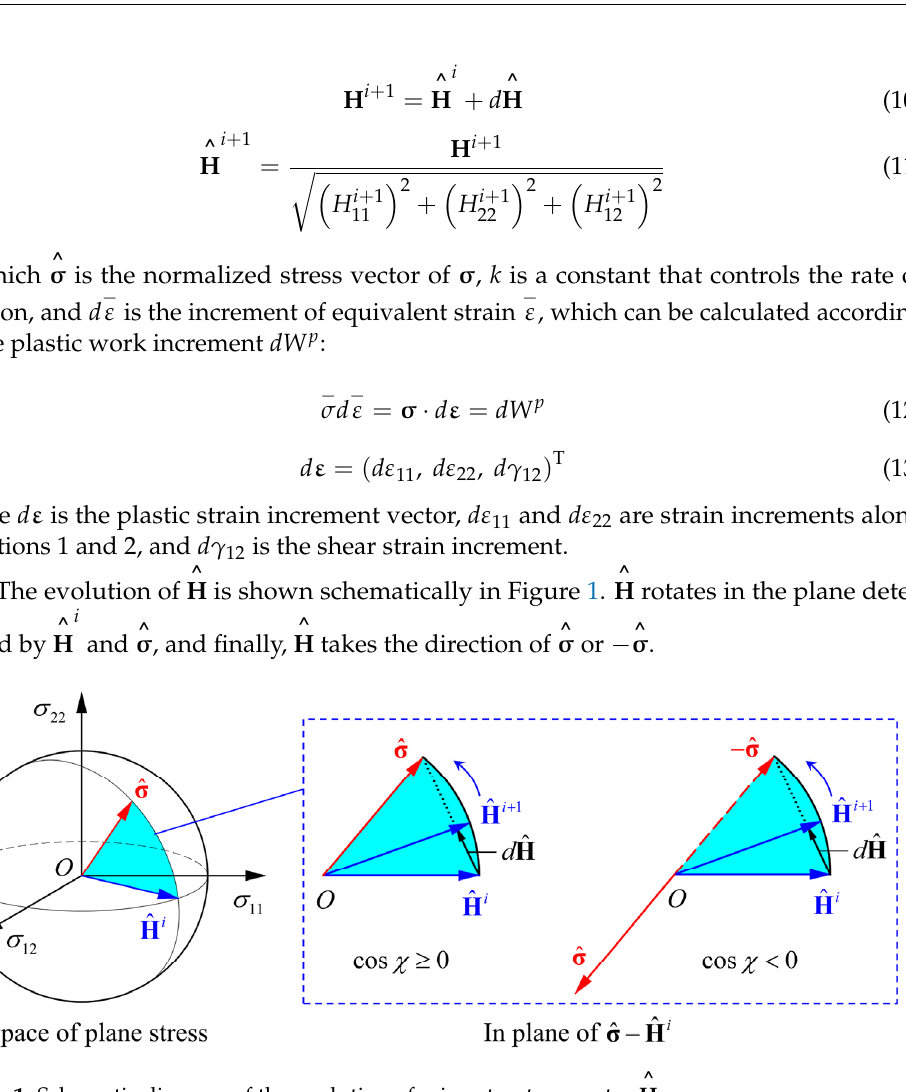
Figure 1. Schematic diagram of the evolution of microstructure vector ˆ H .